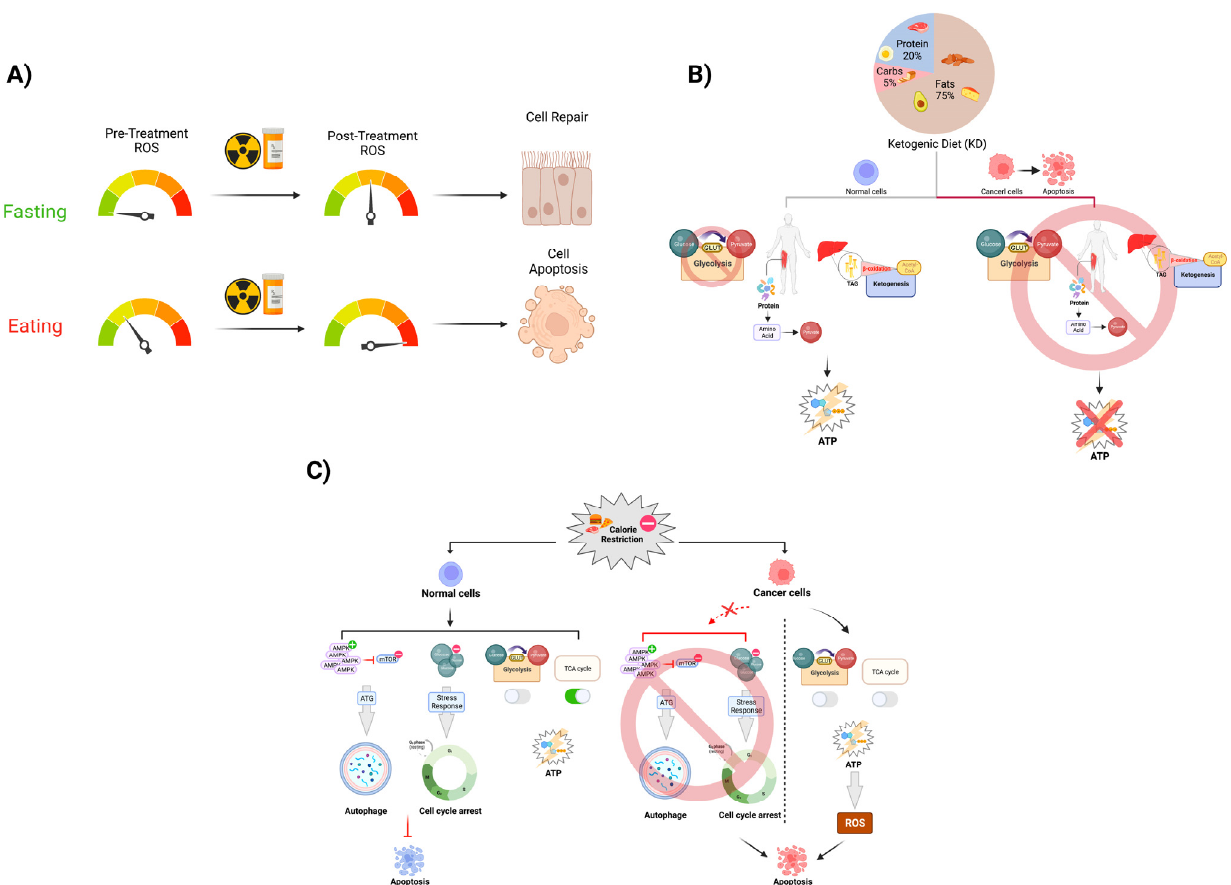
Figure 2. Fasting’s effect on anticancer treatment toxicity. The mechanism of radiation and some chemotherapeutic drugs are largely mediated through the induction of increased levels of oxidative stress-mediated DNA damage in the cell. Most of the oxidative stress in the cell is predominately produced by physiologic metabolic processes. ( A ) During fasting periods in IF, the level of ROS that is produced by the mitochondria is significantly lower than it is during the active metabolism period. By introducing a period of short-term fasting pre- and post-cancer therapy that induces ROS, we expect this dietary modulation to protect normal cells from excess levels of DNA damage due to DNA stress. In this case, more normal cells can repair themselves and survive, while highly metabolic cancer cells are less likely to respond to short-term fasting as they are likely undergoing apoptosis as a result of this. ( B ) As described by the Warburg effect, cancer cells vastly increase their uptake of glucose, developing an overreliance on glycolysis as their primary method of ATP generation. CR utilizes this lack of metabolic flexibility to disproportionately place more oxidative stress on cancer cells than they do on normal somatic cells, thereby leading to apoptosis. ( C ) KD is able to exploit the Warburg Effect as well through purposefully depleting serum glucose via reducing the consumption of carbohydrates. This results in an overall increased reliance on fatty acid beta-oxidation and gluconeogenesis to provide energy and maintain appropriate serum glucose levels, effectively starving cancer cells of glucose and curbing tumor growth